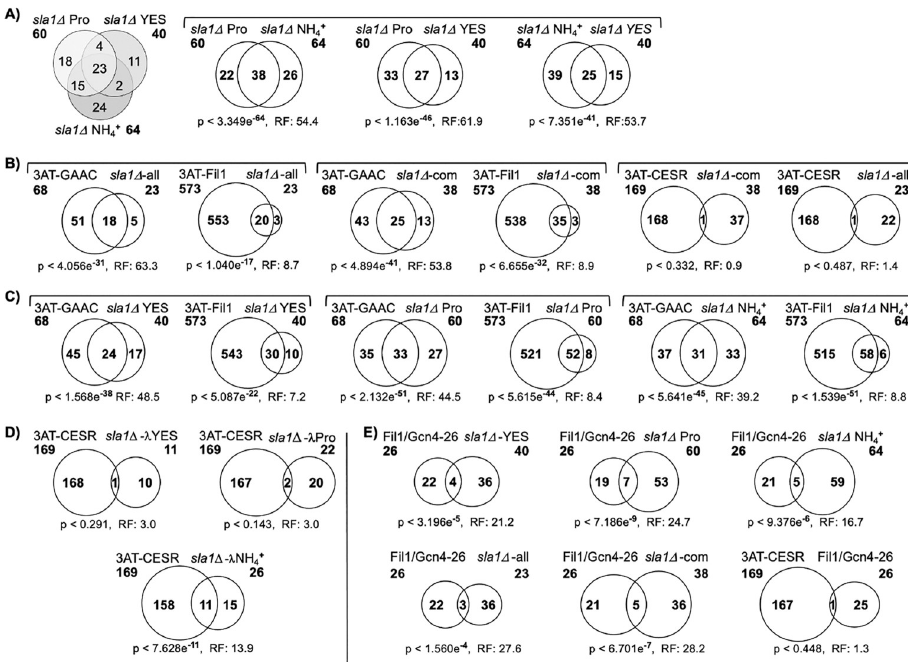
Fig 1. Statistical significance of overlap of sla1 Δ � 1.5x transcriptomes and the representation factors (RF) (see text). A-E) The representation factor (RF) is the number of overlapping genes divided by the expected number of overlapping genes drawn from two independent groups. RF > 1 indicates more overlap than expected of two independent groups and a RF < 1 indicates less overlap than expected. 3AT-GAAC and 3AT-CESR are from [46] in which these gene groups are referred to as clusters 3 and 2 respectively, and are considered analogous to a Gcn2-dependent GAAC response and a CESR response respectively. 3AT-Fil1 represents genes induced in response to 3AT in gcn2 + vs gcn2 Δ cells [47]. Fil1/Gcn4-26 represents a core group of 26 genes directly bound by the Fil1 and Gcn4 transcriptional activators of GAAC genes in their respective genomes [47]. The sla1 Δ Pro, sla1 Δ YES and sla1 Δ NH4 + gene sets are described in the main text, as are the sla1 Δ -all and sla1 Δ -com sets, and the sla1 Δ - λ Pro, sla1 Δ - λ YES and sla1 Δ - λ NH4 + gene sets. Bold font numerals under these names indicate gene number in the set. ( YHI9 ), arg3 + ( ARG3) , arg5 + ( CPA1 ), arg12 + ( ARG1 ), asn1 + ( ASN1 ), gdh2 + ( GDH2 ), pas1 + ( PCL5 ), SPAC56E4.03 ( ARO8 ) and aca1 + , involved in arginine, asparagine, glutamine, and glutamic acid metabolism ( S2A Table ) . Six of these were upregulated in the sla1 Δ -all gene set (S2A Table). GO analysis of the 23 genes in the sla1 Δ -all set revealed multiple of the same pro- cesses involved in arginine, asparagine, glutamine, and glutamic acid metabolism as well as DNA processes (S2B Table). Thus, amino acid metabolic genes recognized as involved in cohe- sive processes are constitutively over-expressed in sla1 Δ cells relative to sla1 + cells in all three growth media. Among the 15 upregulated genes shared by sla1 Δ cells grown in EMM (but not YES), were arg3 + , arg5 + , asn1 + , plus two involved in membrane transport, and others involved in related small molecule metabolism (S1 Table). We also performed GO analysis on genes in the sla1 Δ sets that do not overlap (S3A–S3C Table). The 11 genes in the YES set that do not overlap with either of the two other sets were designated as sla1 Δ - λ YES. The 22 and 26 genes in the sla1 Δ Pro and NH4 + sets that do not overlap with eachother were designated sla1 Δ - λ Pro and sla1 Δ - λ NH4. Interestingly, 3 of the 11 genes specific to sla1 Δ - λ YES and 16 of the 22 genes specific to sla1 Δ - λ Pro were linked to mul- tiple GO related metabolic processes at p < 0.01 (S3A and S3B Table). By contrast, the 26 genes specific to sla1 Δ - λ NH4 yielded no GO terms at p < 0.01 (not shown); only when the stringency was lowered to p < 0.05 was a single GO term revealed (S3C Table).